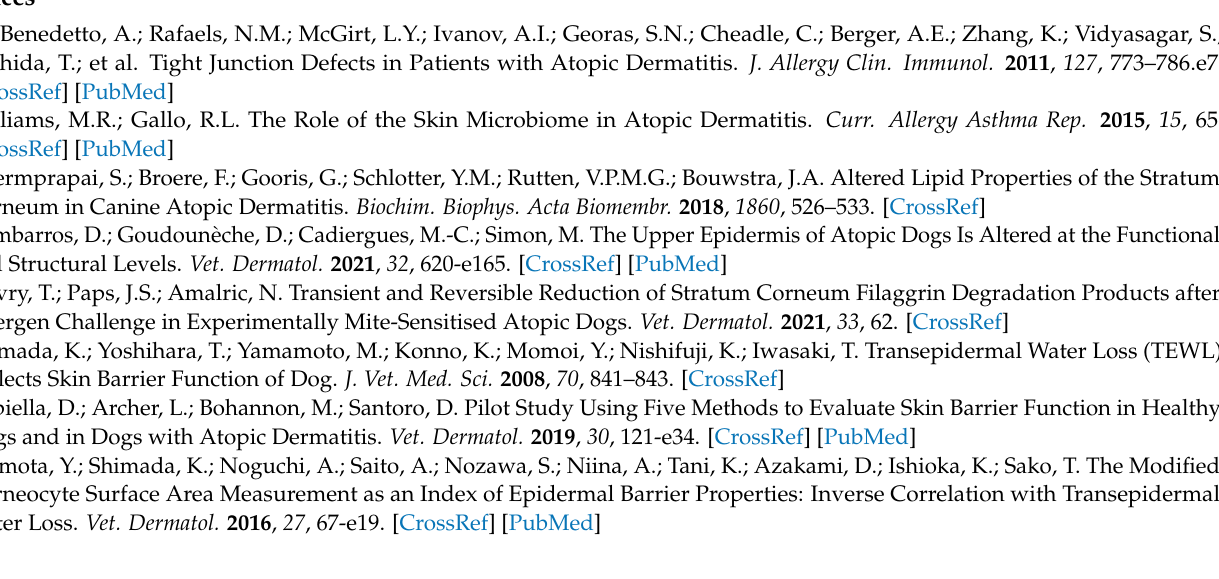
figshare. Dataset. https://doi.org/10.6084/m9.figshare.20102387.v1 (accessed on 23 June